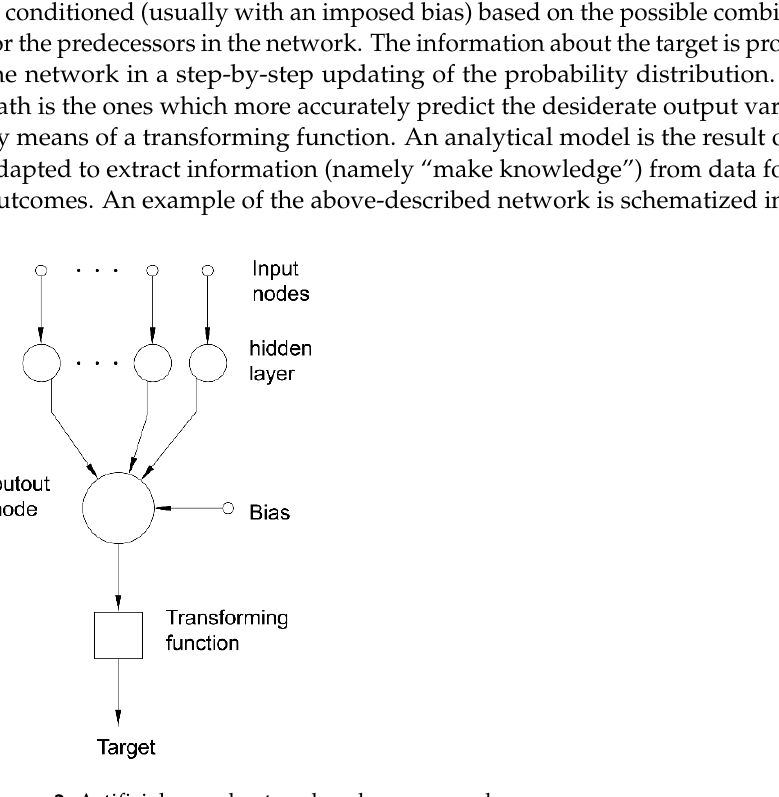
Figure 2. Artificial neural networks scheme example.